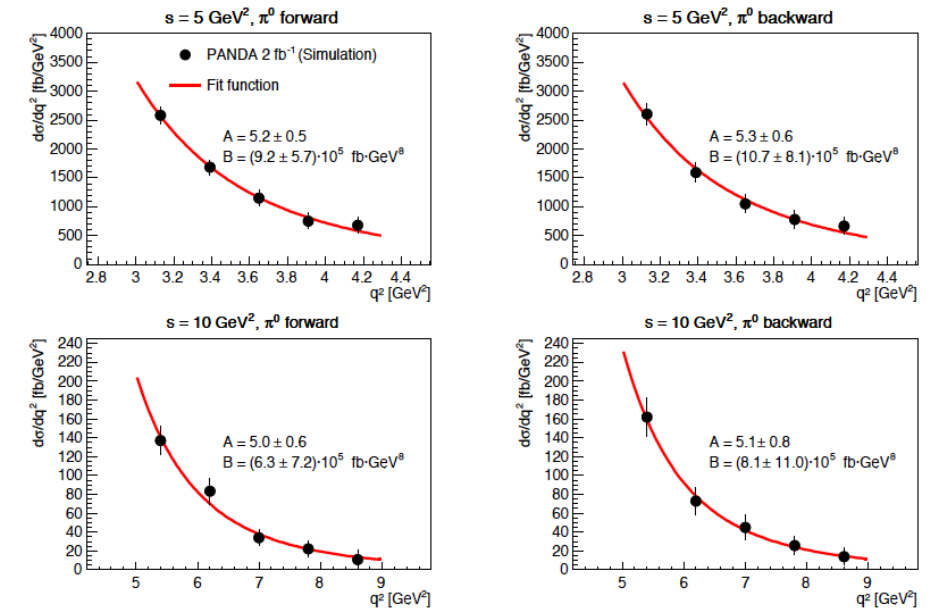
Figure 2. The ¯ pp → γ ∗ π 0 → e + e − π 0 di ff erential cross sections as a function of q 2 obtained from the simulations for s = 5 GeV 2 and s = 10 GeV 2 , in both the t − ( π 0 forward) and the u − ( π 0 backward) channel kinematic regimes [32]. The resulting cross section are fitted with the theoretical leading twist predictions (see [32] and references therein). The parameters A and B are fit